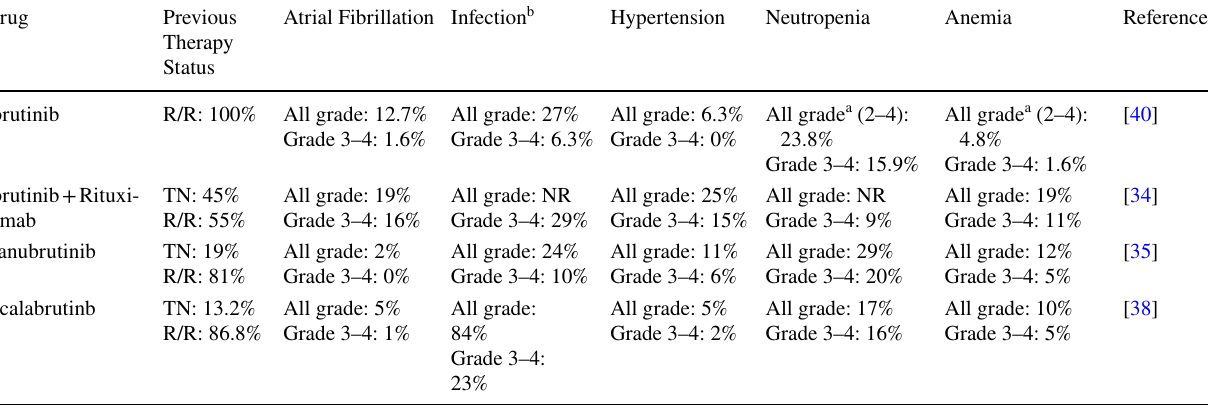
Table 3 Summary of common adverse events in clinical trials using BTKi